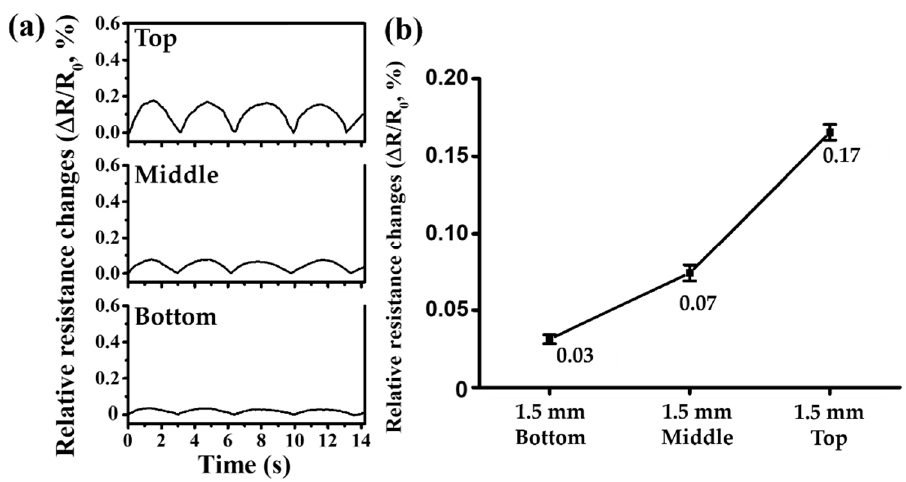
Figure 6. Experimental results of the relative electrical resistance changes in the vessels of 1.5 mm diameter: ( a ) changes in relative electrical resistances at the Top, Middle, and Bottom positions; ( b ) graph of mean relative changes in electrical resistances at the Top, Middle, and Bottom positions.